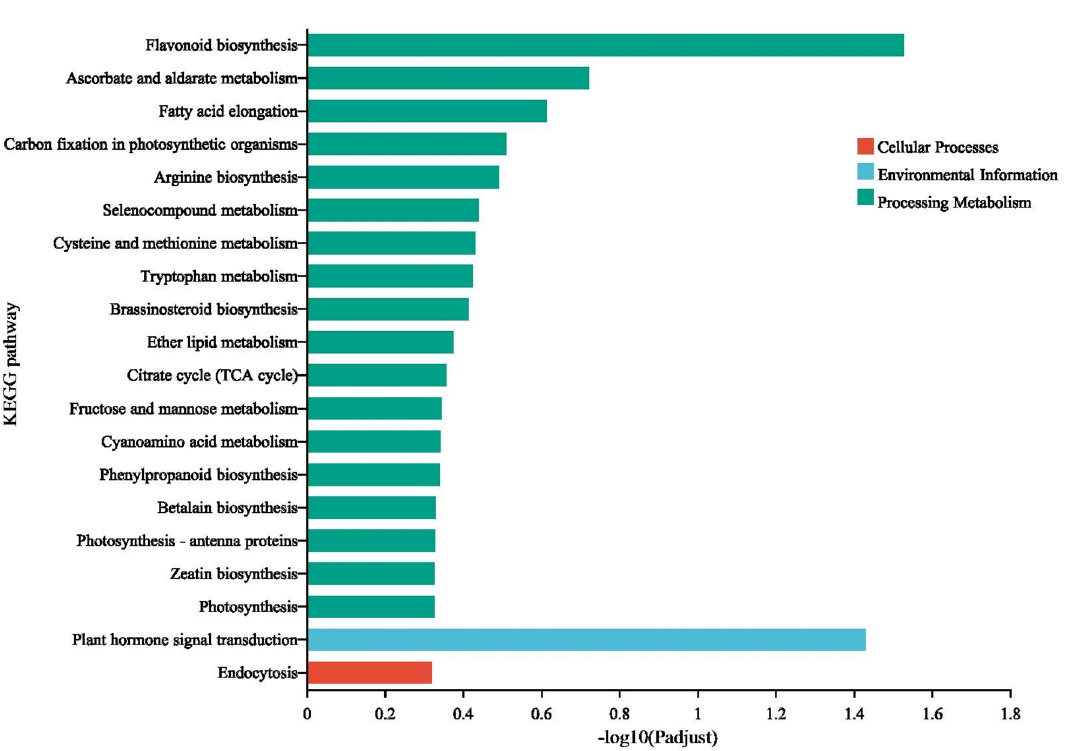
Figure 10. KEGG analysis of intersection of DEGs between rootstocks and scions of two grafted